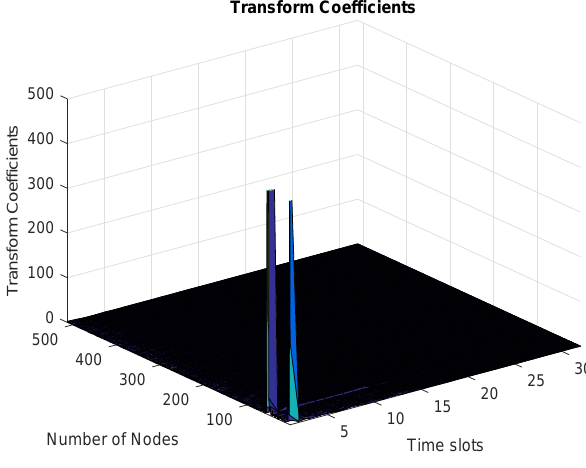
Figure 5. The transform coefficients employing GKB-DCT as a 2D transform basis.